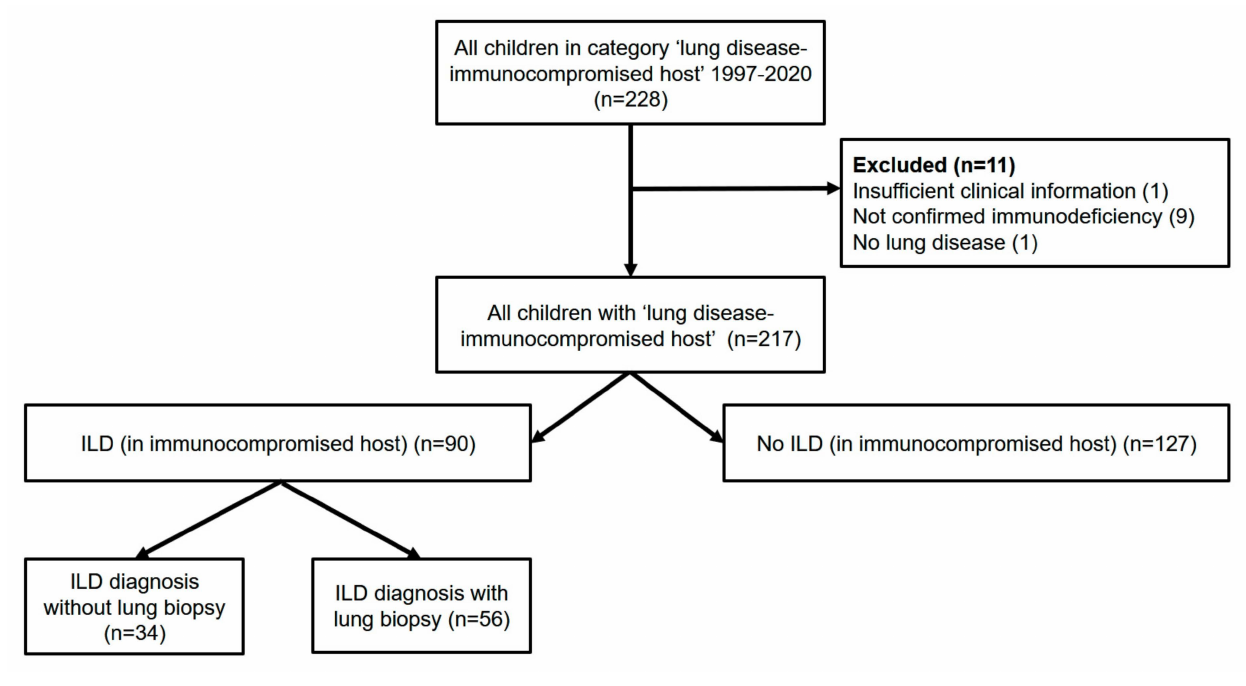
Figure 1. Overview of patients included and excluded. Table 1. Clinical characteristics of patients with immunodeficiency and with ILD or without